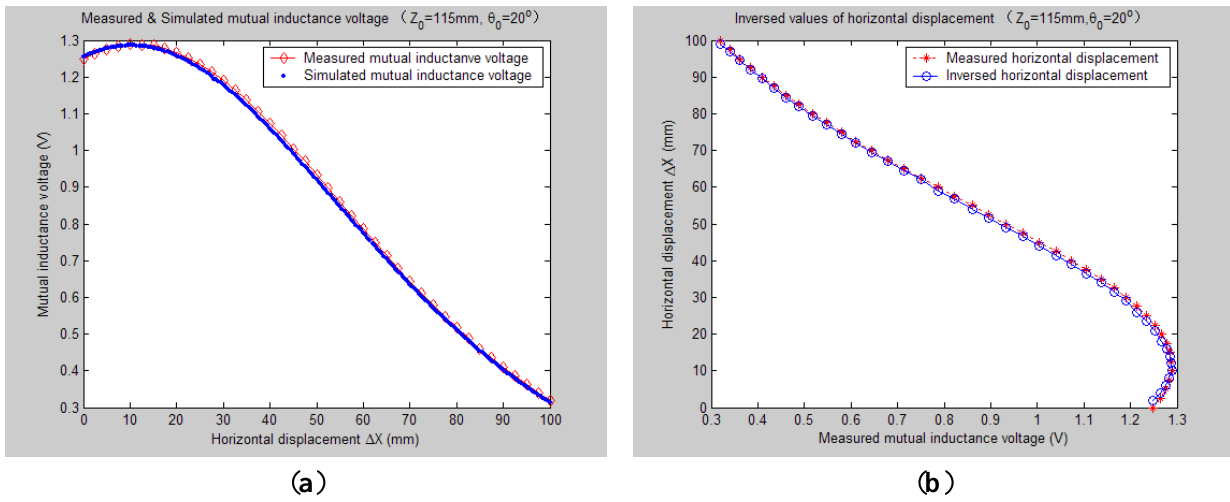
Figure 11. Horizontal displacement inverse results of H-type sensor ( θ